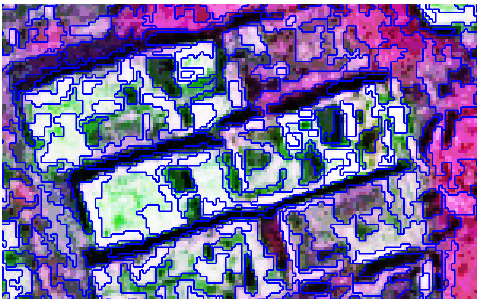
Figure 4. Segmented image (buildings) with scale 30, the shape and compactness parameters are 0.2 and 0.8, respectively.